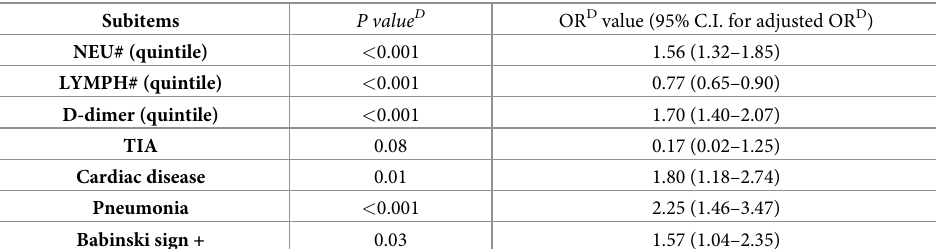
Table 2. Regression analysis of significant relative subitems to poor prognosis in AIS.